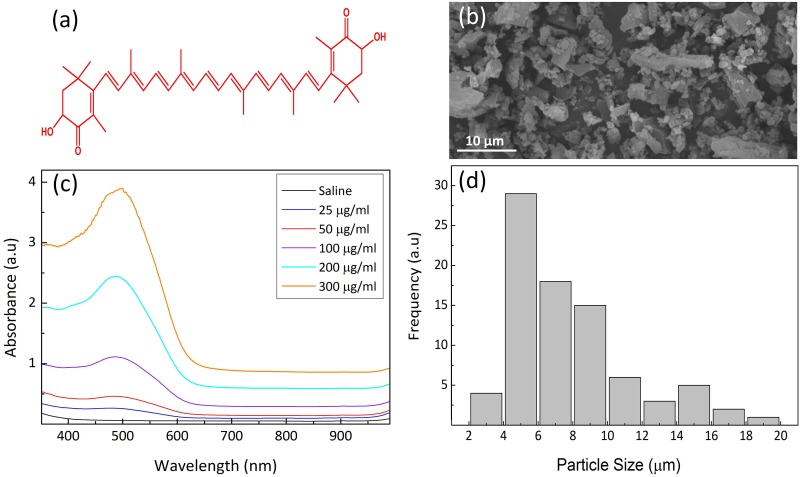
Characterization of Astaxanthin (AXT).(a) Chemical structure, (b) TEM image (×2000, 20 kV), (c) absorbance as a function of wavelength and concentration, and (d) distribution of AXT particles sizes. Note that the average particle size was measured to be 7.9 ± 3.6 μm.